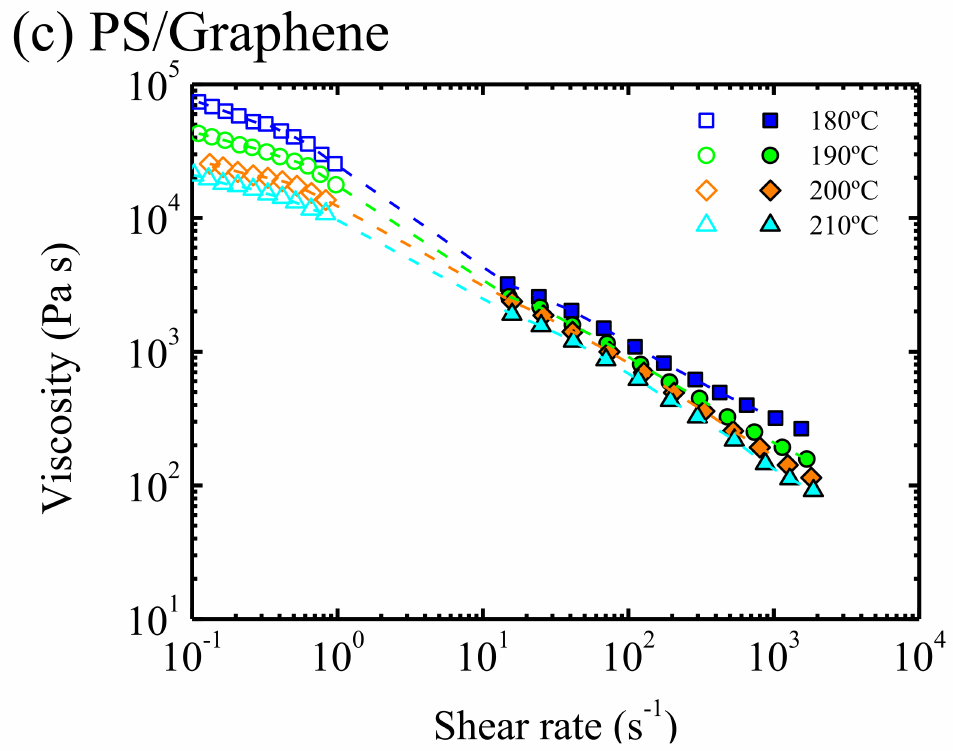
Figure 2. Viscosity as a function of shear rate for ( a ) PS, ( b ) PS/MWCNT, and ( c ) PS/PS/graphene. Open symbols correspond to data obtained with plate–plate geometry, whereas filled symbols correspond to data obtained by capillary extrusion rheometer [30]. The lines correspond to a modified Carreau Yasuda paper, see reference [30]; for Figure 2c, the discontinuous lines are to guide the eye. Reprinted with permission from [30]. Copyright 2016 The Society of Rheology.